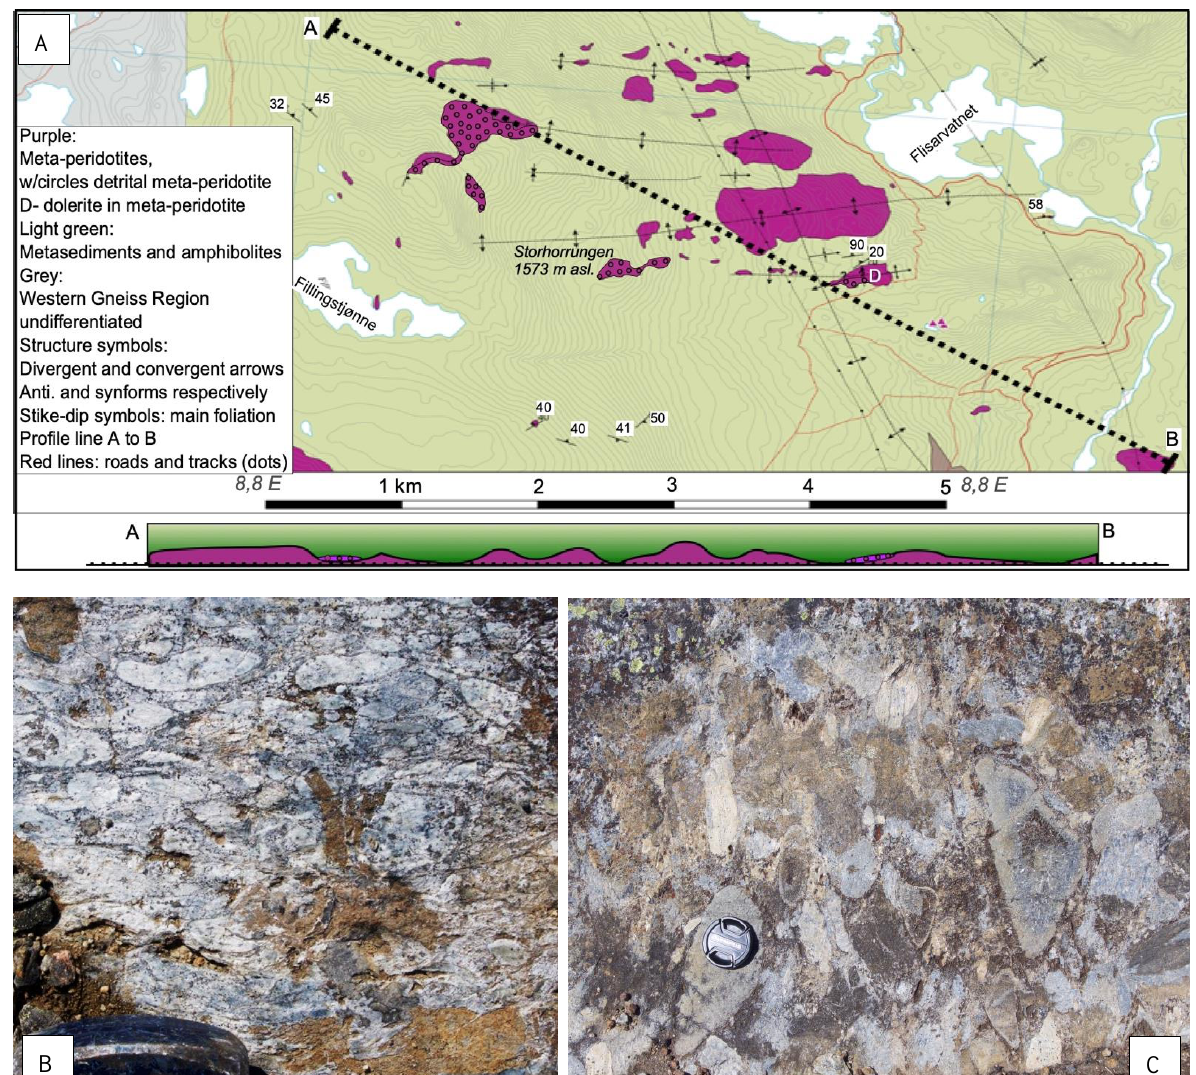
Figure 3. ( A ) Map with profile (dotted line) from the magma-poor to magma-rich transition zone near Lesja (Figure 1 for location). Notice that metaperidotites crop out along the hinges of Late Scandian E – W antiforms. Some have rims of metaperidotite breccias and detrital metaperidotites are shown as bright purple in the cross-section. ( B ) Peak-Scandian metamorphic mega-porphyroblasts (brown) of forsterite (Fo 93 ) overgrowing an already-hydrated and carbonated detrital soapstone conglomerate with rounded pebbles/cobbles. Hammer head for scale is 15 cm. ( C ) A metaperidotite (fault?) breccia with angular fragments. Notice the concentric alteration of fragments, and notice also that the brown, weathered olivine crystals overgrow the fragments and matrix shown in both panels. Mapping by J. Jakob, G. Mohn and O. Quintela.